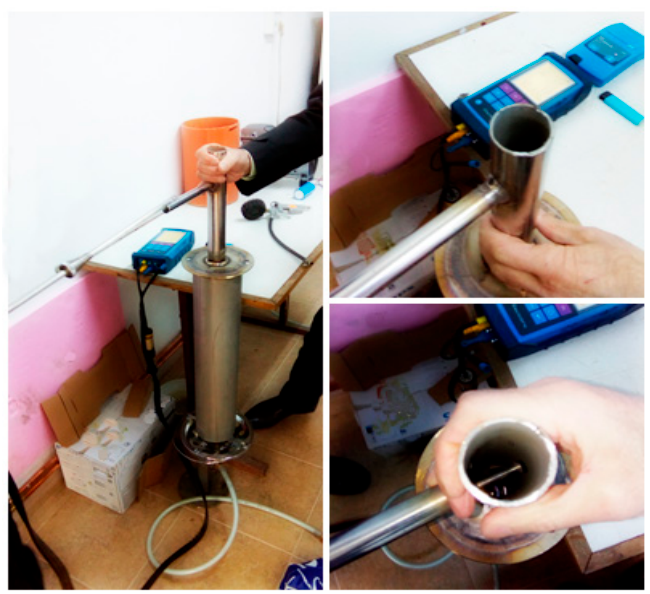
Figure 5. Analyzer for combustion gases investigation.